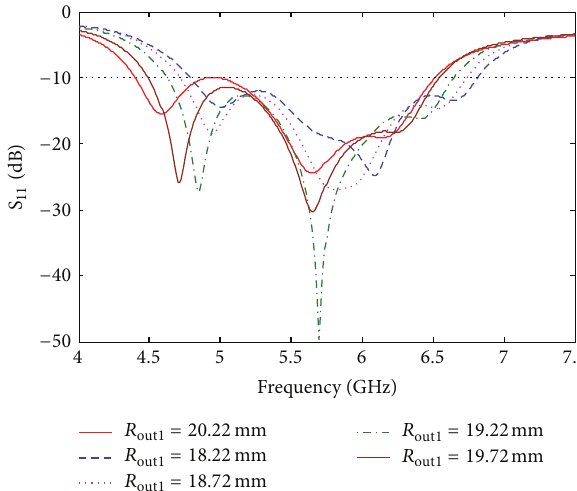
with 𝑊 = out 1 = 15.29 mm, 𝑅 = in 1 in 2